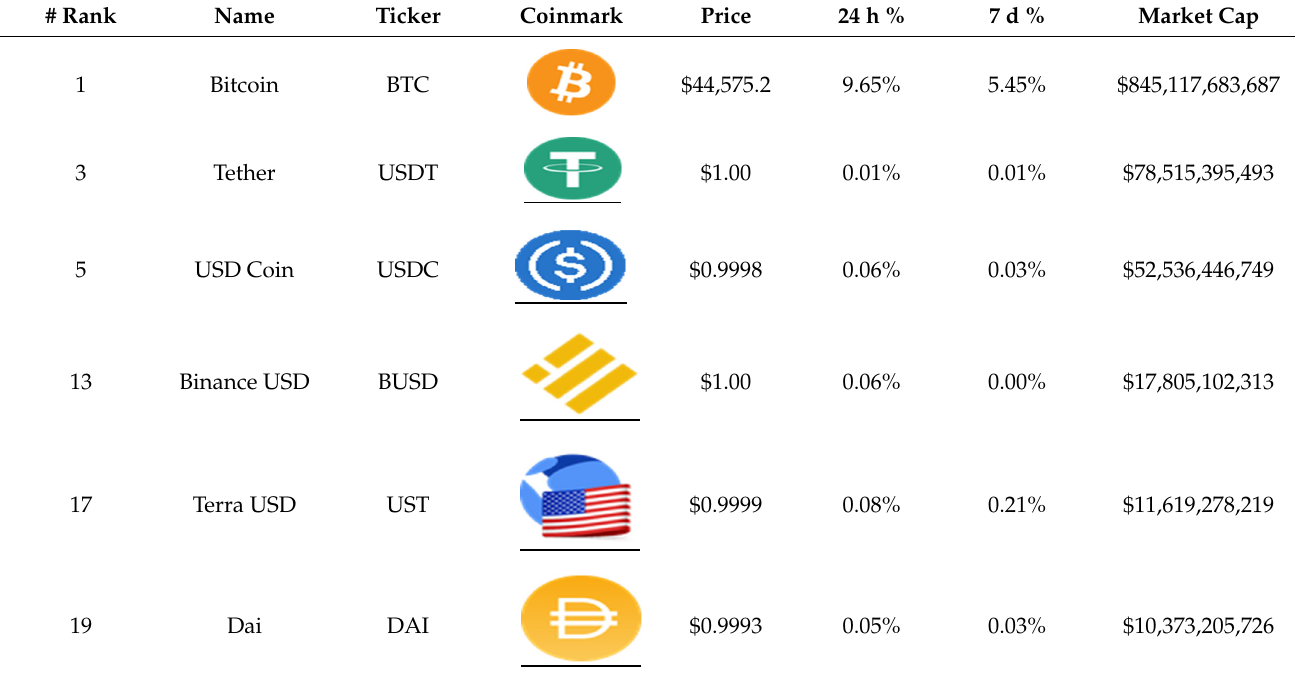
Table 1. Characteristics and market capitalization of Bitcoin and stablecoins.